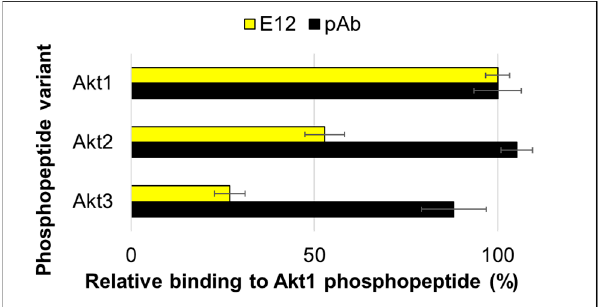
Figure 7. Binding of an Akt1-pTBD to corresponding peptides from Akt2 and Akt3. A set of biotinylated phosphopeptides containing the Akt1 sequence, the Akt2 corresponding sequence (SDGATMKpTFCGTPE) and the Akt3 corresponding sequence (TDAATMKpTFCGTPE) were immobilized by neutravidin. Binding of the E12 variant and a commercially produced polyclonal antibody (pAb) were determined by an ELISA. Error bars represent standard deviation of triplicate measurements.